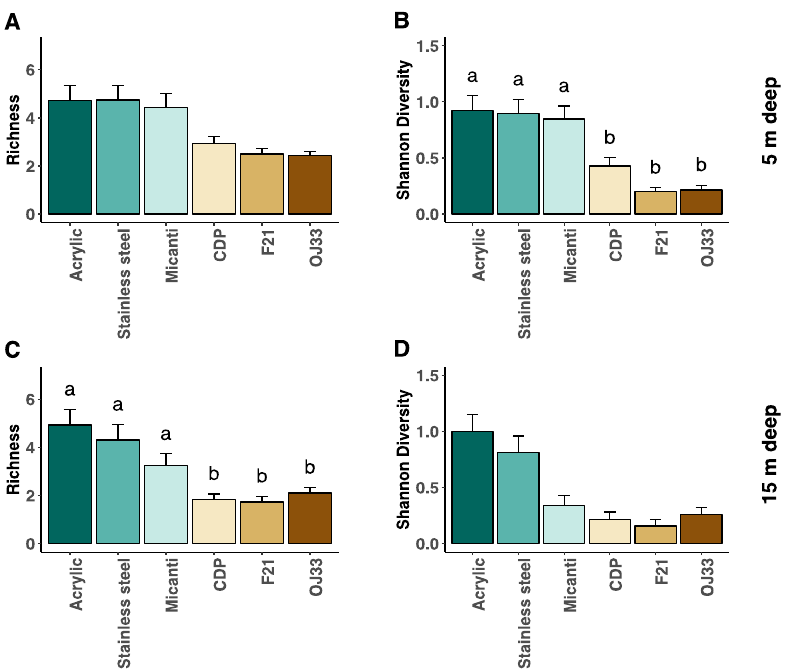
Figure 8. Mean richness ( A , C ) and Shannon diversity index ( B , D ) between treatments (mean + SE) at two depths (5 and 15 m). Letters a and b above SE bars indicate significant differences (among treatments from the Dunn’s test with an experiment-wise error rate of 0.05).